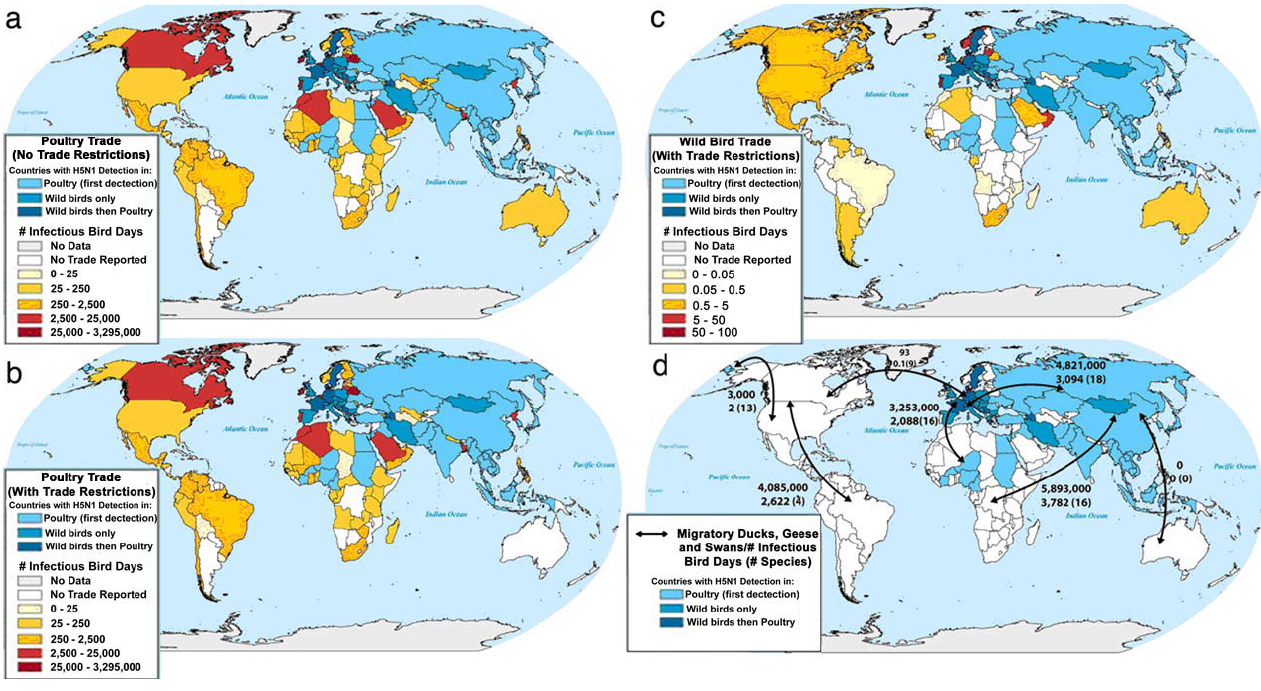
Fig. 3. Predicted risk of HP-H5N1 introduction from countries that have had H5N1 outbreaks (in blue). (a–c) Risk was estimated as number of infectious bird days caused by trade in: live poultry with no trade restrictions (a), live poultry with no exports from countries reporting H5N1 in poultry (b), and captive wild birds with no exports from countries reporting H5N1 in poultry (c) as in b. (d) Estimated number of ducks, geese, and swans migrating between mainland continents, number of infectious bird days, and number of species (in parentheses). Reproduced from Kilpatrick et al.